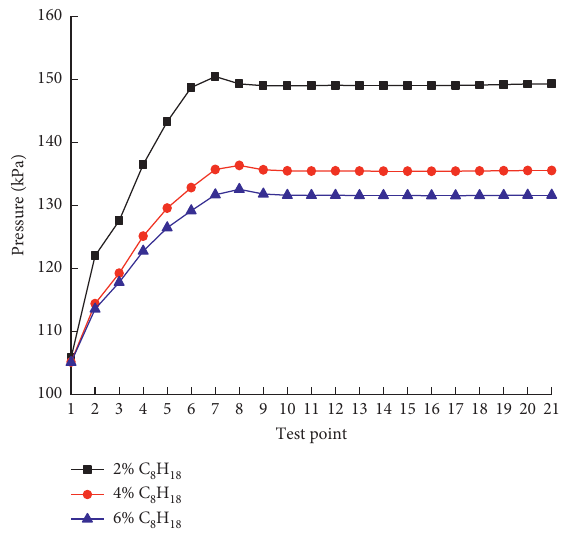
Figure 20: Curves of flame propagation velocity under different gas concentrations.